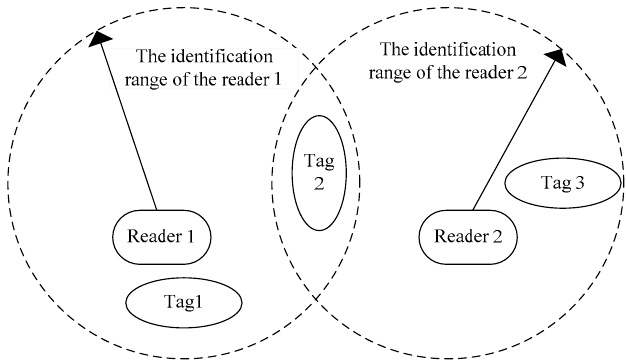
Figure 2. Tag-reader collision diagram.